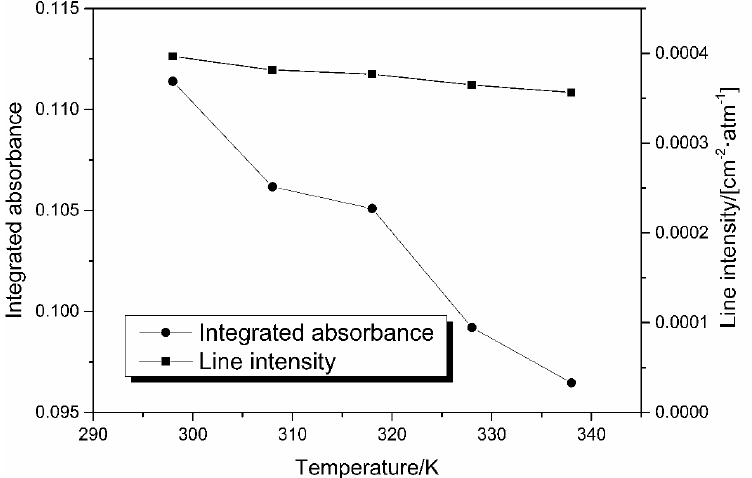
Figure 7. Integrated absorbance as a function of P · X · L (T = 298–338 K, P = 1 atm). Table 2. Line intensity (10 − 4 cm − 2 ·atm − 1 ) values from database and calculated values.